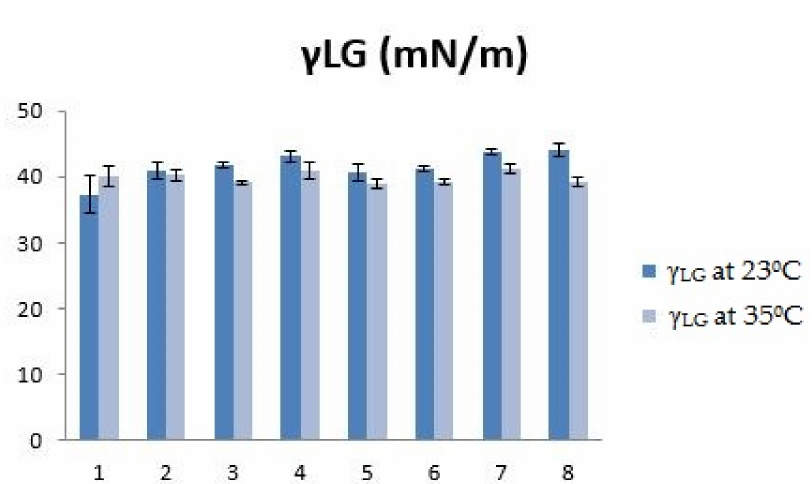
Figure 3. Graphical representation of the comparative values of the surface tension γ LG for the eight samples analyzed at the two temperatures (23 ◦ C and 35 ◦